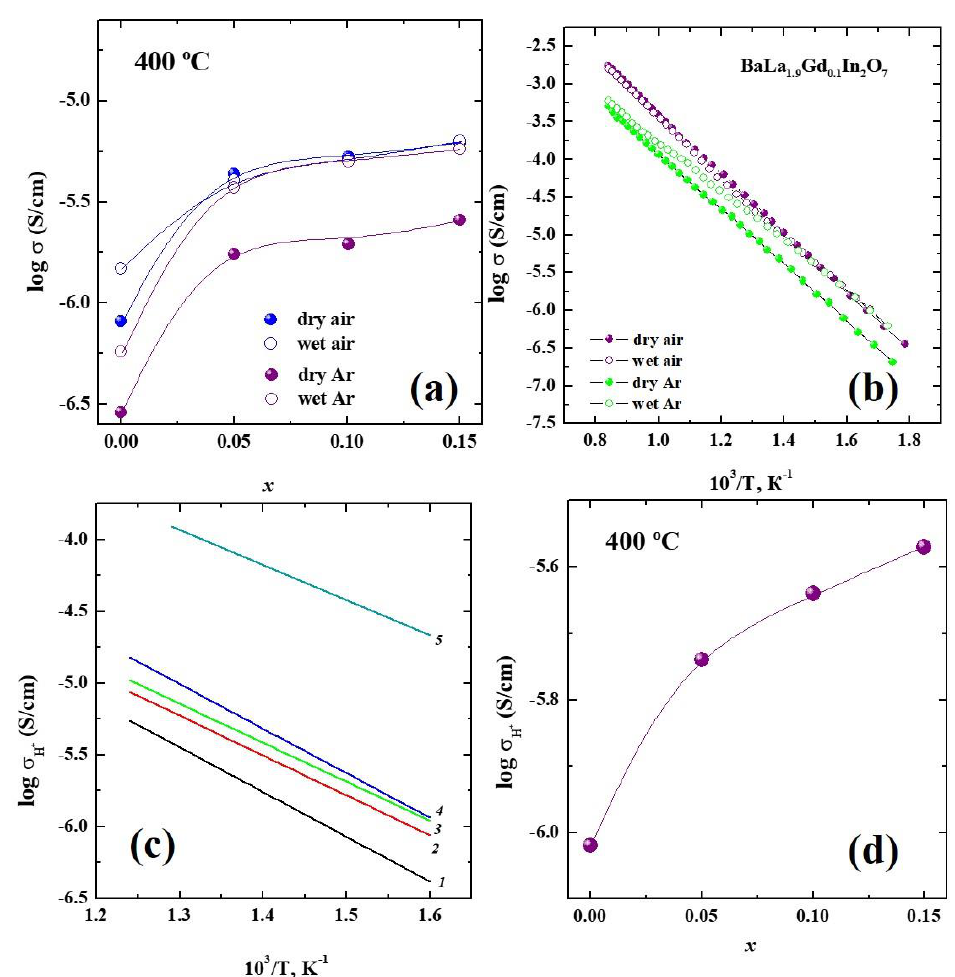
Figure 4. ( a ) The concentration dependencies and ( b ) temperature dependencies of conductivities for the compositions of BaLa 2 – x Gd x In 2 O 7 obtained under different conditions. ( c ) The temperature dependencies and ( d ) concentration dependency of protonic conductivities of the compositions of BaLa 2 – x Gd x In 2 O 7 with x = 0 (1), x = 0.05 (2), x = 0.10 (3) and x = 0.15 (4) and for the composition BaLa 1.7 Ba 0.3 In 2 O 6.85 (5).